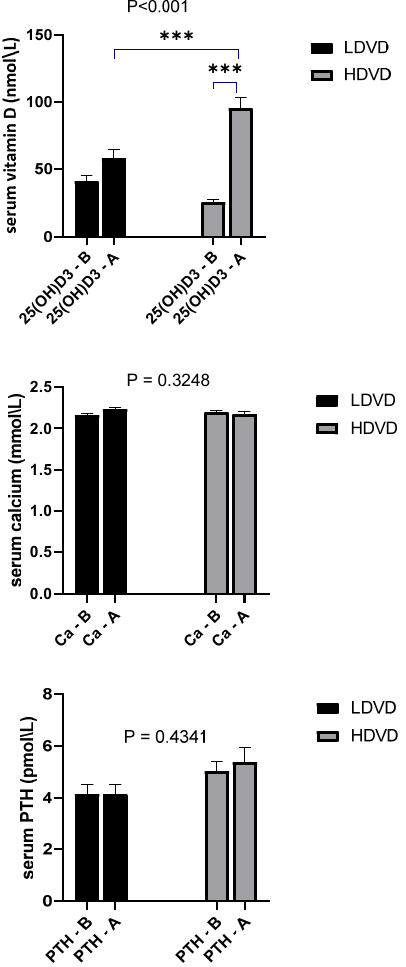
Figure 2. Comparison of fasting serum levels of 25(OH)D3, Ca, and PTH. Comparison was carried out between LDVD and HDVD groups and their levels before (B) and after (A) treatment of the same group using two-way analysis of variance followed by Tukey’s multiple comparison test. Bars represent the serum concentration of biochemical variable. Error bars represent standard error of the mean (SEM). Exact p -values are recorded on graphs. Data were considered significant if p < 0.05. *** p <